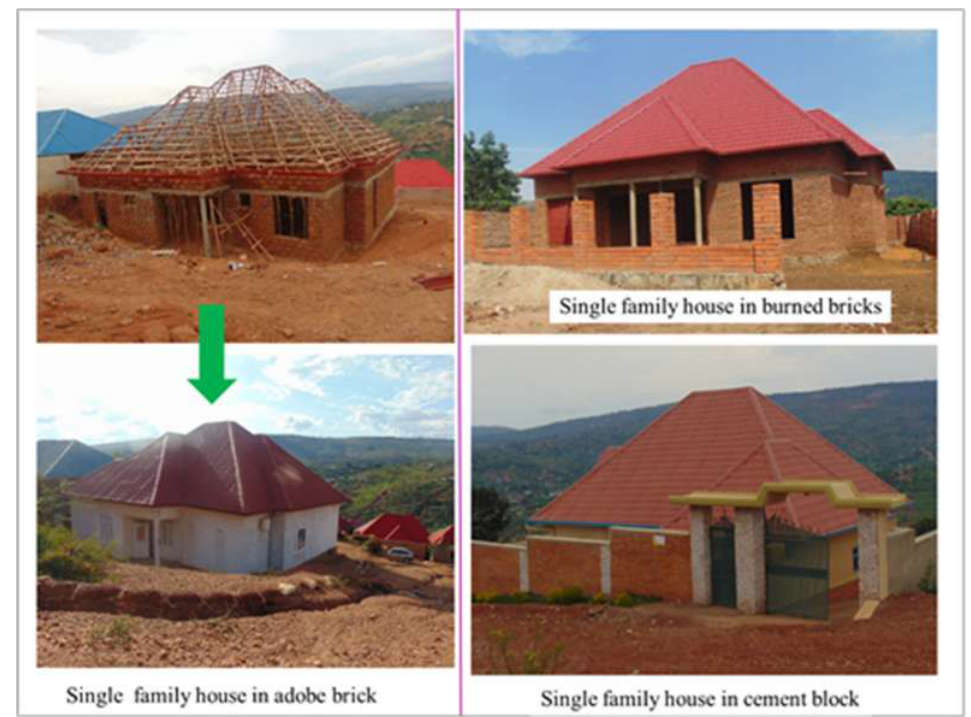
Figure 3. Model for single-family houses under development in Kigali city. Data source: field survey